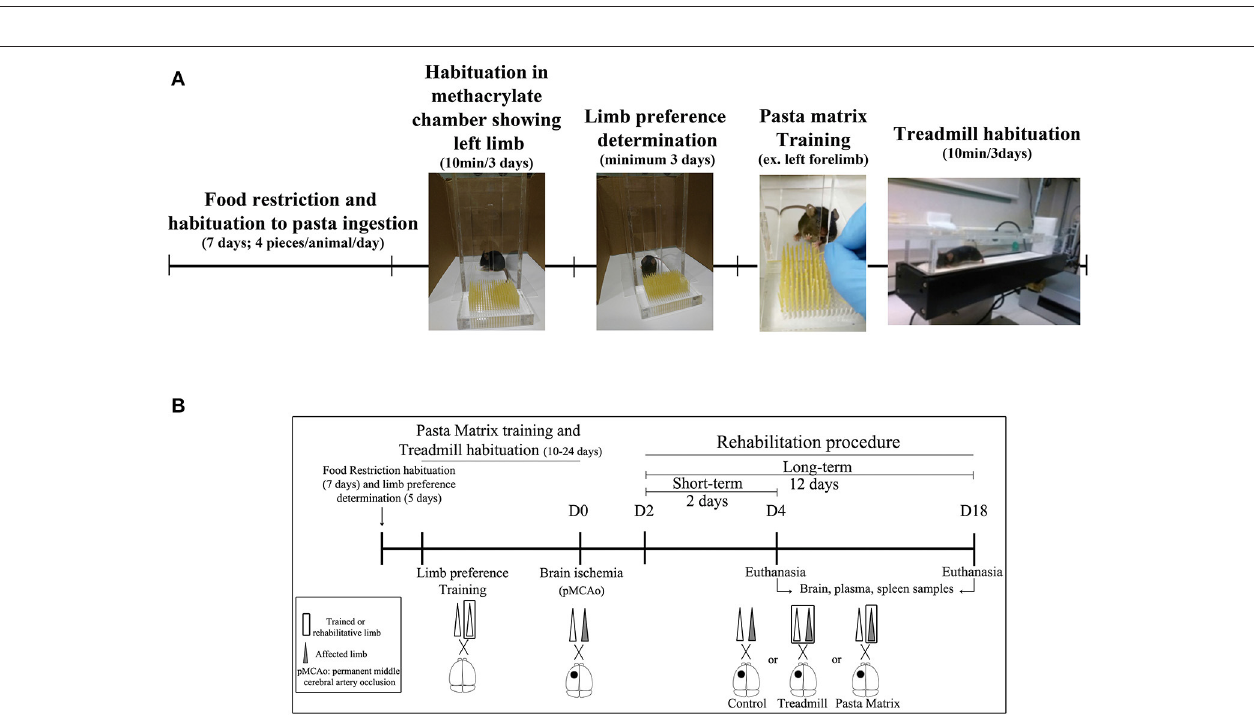
FIGURE 2 | Experimental mice procedure. (A) Scheme of animal habituation and training to pasta matrix and treadmill rehabilitation protocols. (B) The experimental design overview: from food restriction and pasta matrix training/habituation to cerebral ischemia and rehabilitation protocols. D, day.